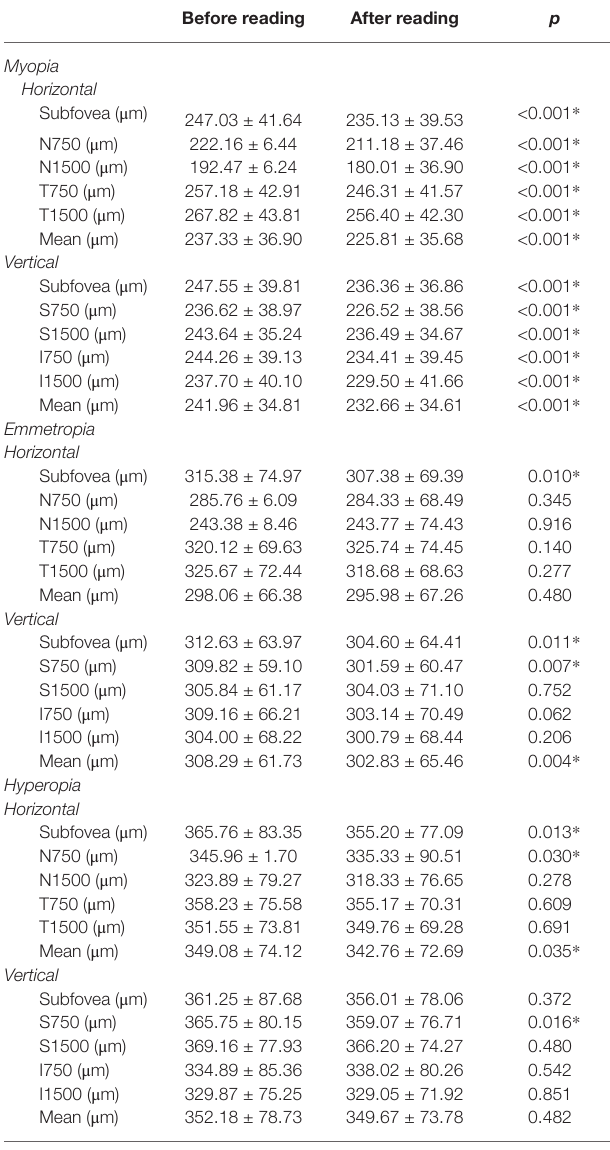
TABLE 5 | Comparisons of choroidal thickness (CT) before and after accommodation in myopia, emmetropia and hyperopia groups. Before reading After